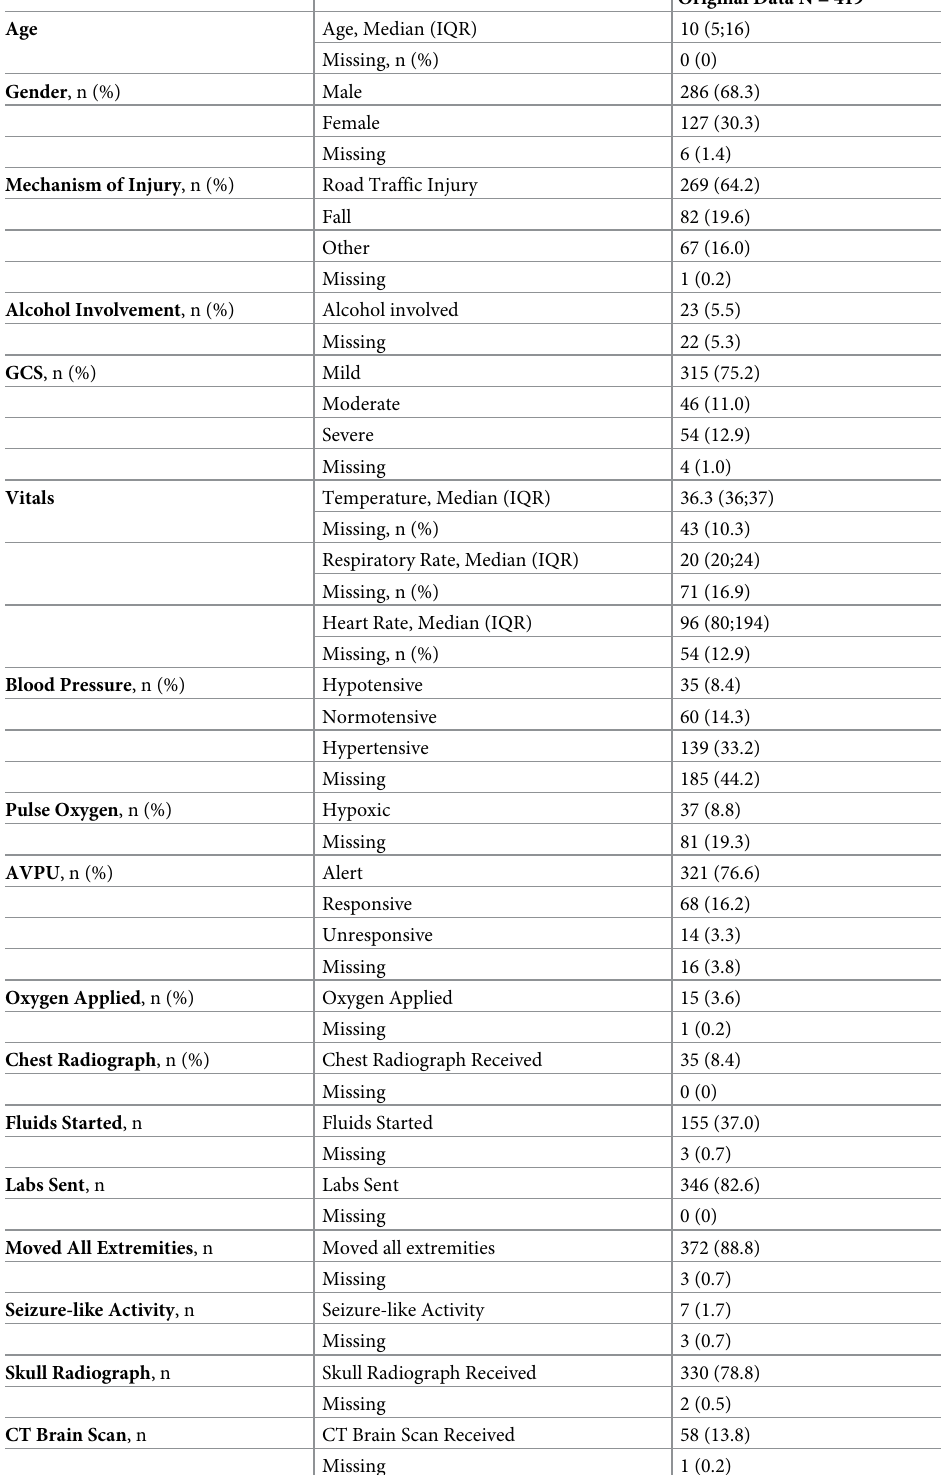
Table 1. Patient demographics and injury